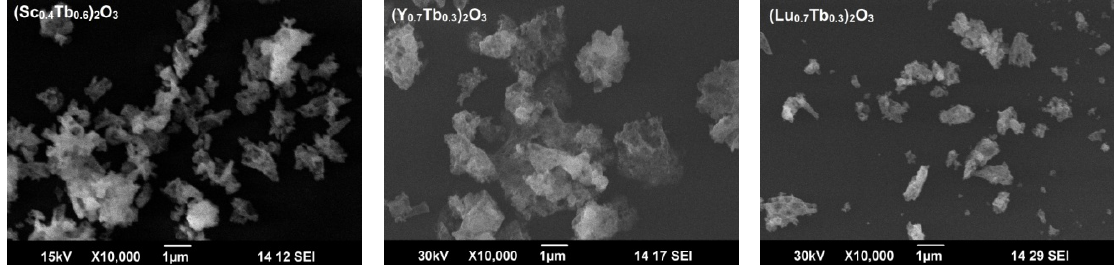
Fig. 1 SEM images of the powders of (Sc 0.4 Tb 0.6 ) 2 O 3 , (Y 0.7 Tb 0.3 ) 2 O 3 , and (Lu 0.7 Tb 0.3 ) 2 O 3 after the